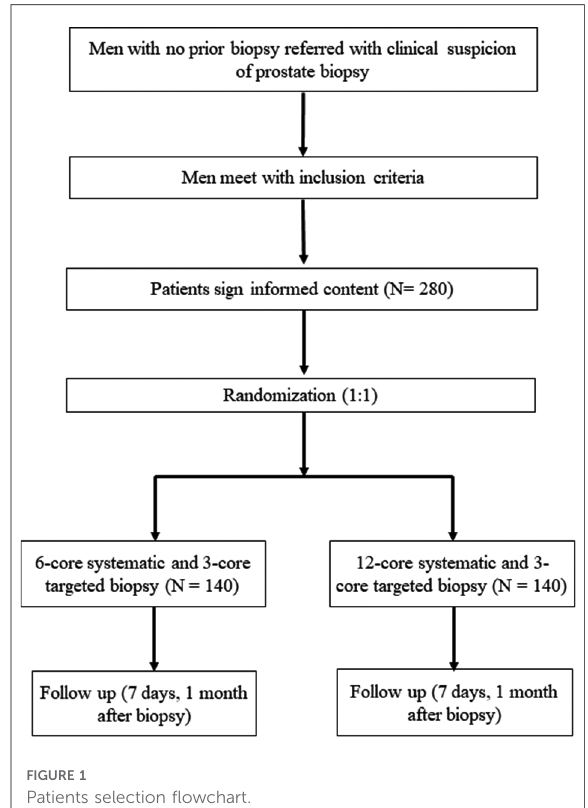
FIGURE 1 Patients selection fl